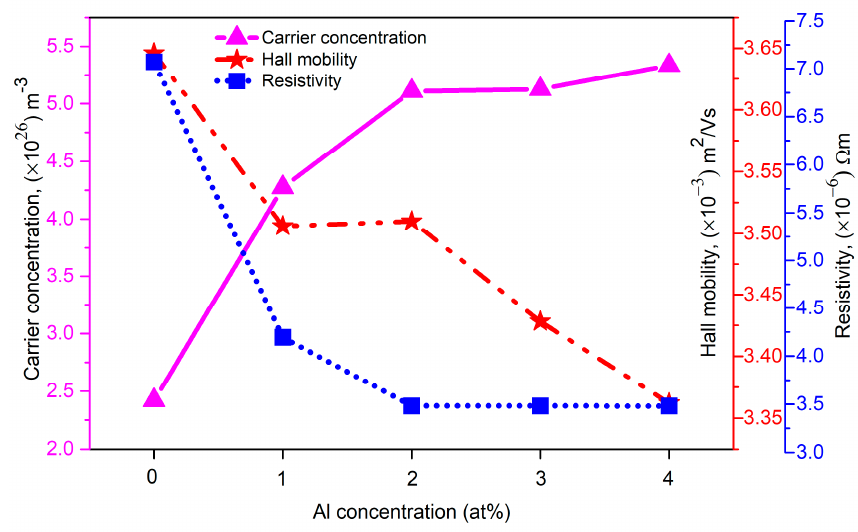
Figure 7. The hall mobility, carrier concentration, and resistivity (Gd, Al) of co-doped ZnO films at various Al concentrations. Table 4. The electrical values of (Gd, Al) co-doped ZnO films at various Al concentrations. Al Concentration